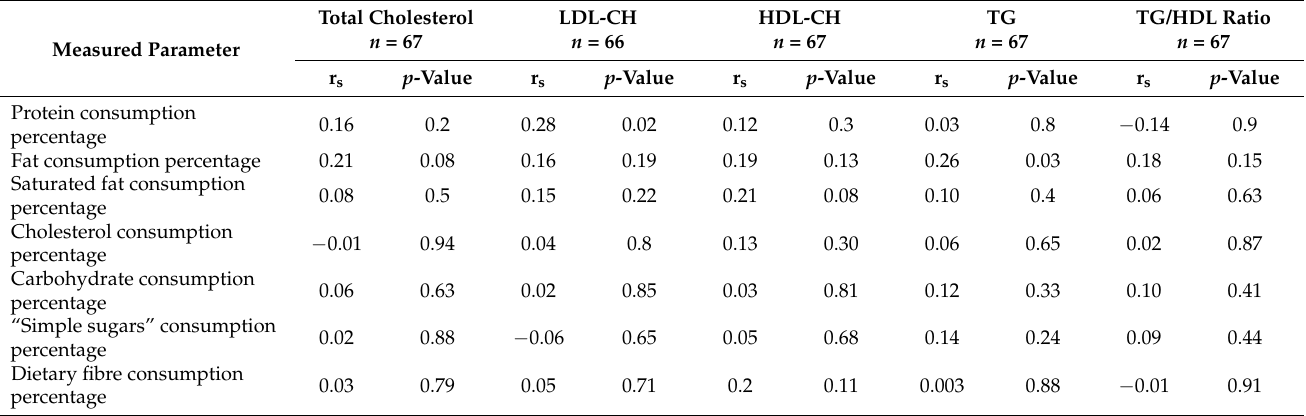
Table 7. The correlation between macronutrient consumption and measured parameters of lipid profile in children after dietary